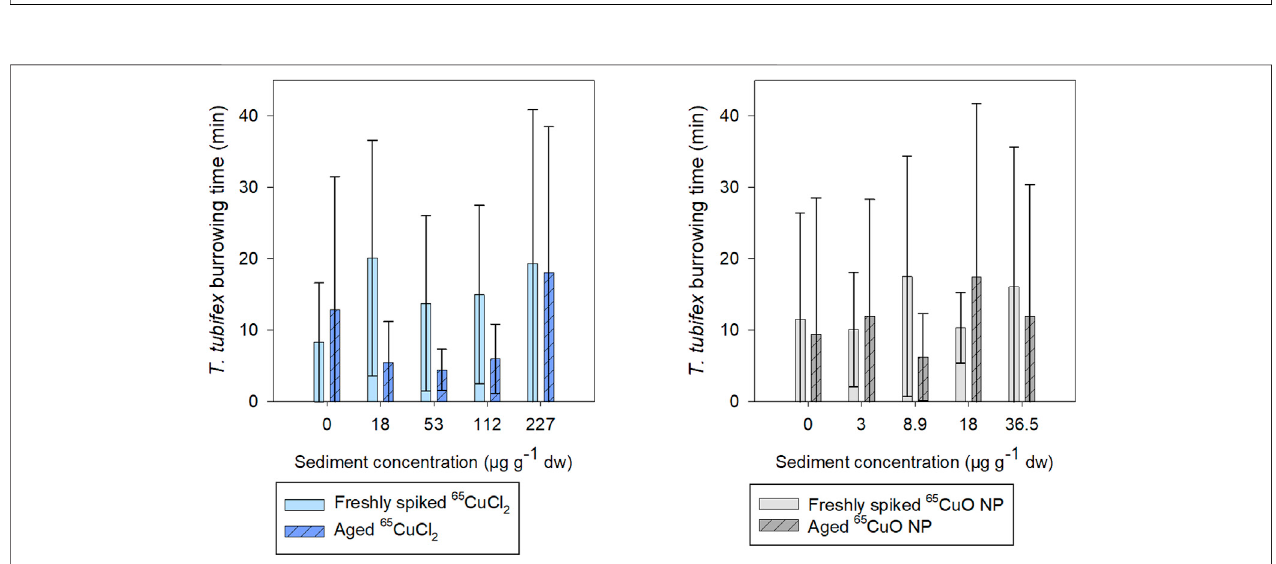
FIGURE 3 | Time until T. tubifex was completely buried in sediment after initiation of exposure in freshly spiked sediment (full bars) or aged sediment (scratched bars). Worms were exposed in sediment with 65 CuCl 2 [blue, (A) ] or 65 CuO NPs [gray, (B) ] at fi ve concentrations. Bars represent the mean time for all four worms to be completely burrowed ± SD, n (cid:1)